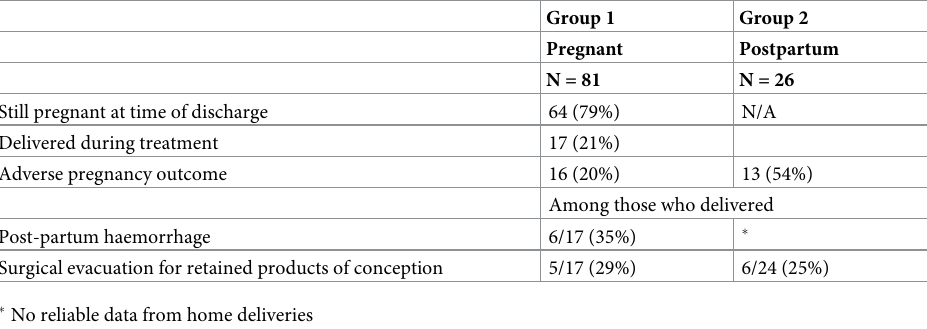
Table 4. Obstetric and pregnancy outcomes.